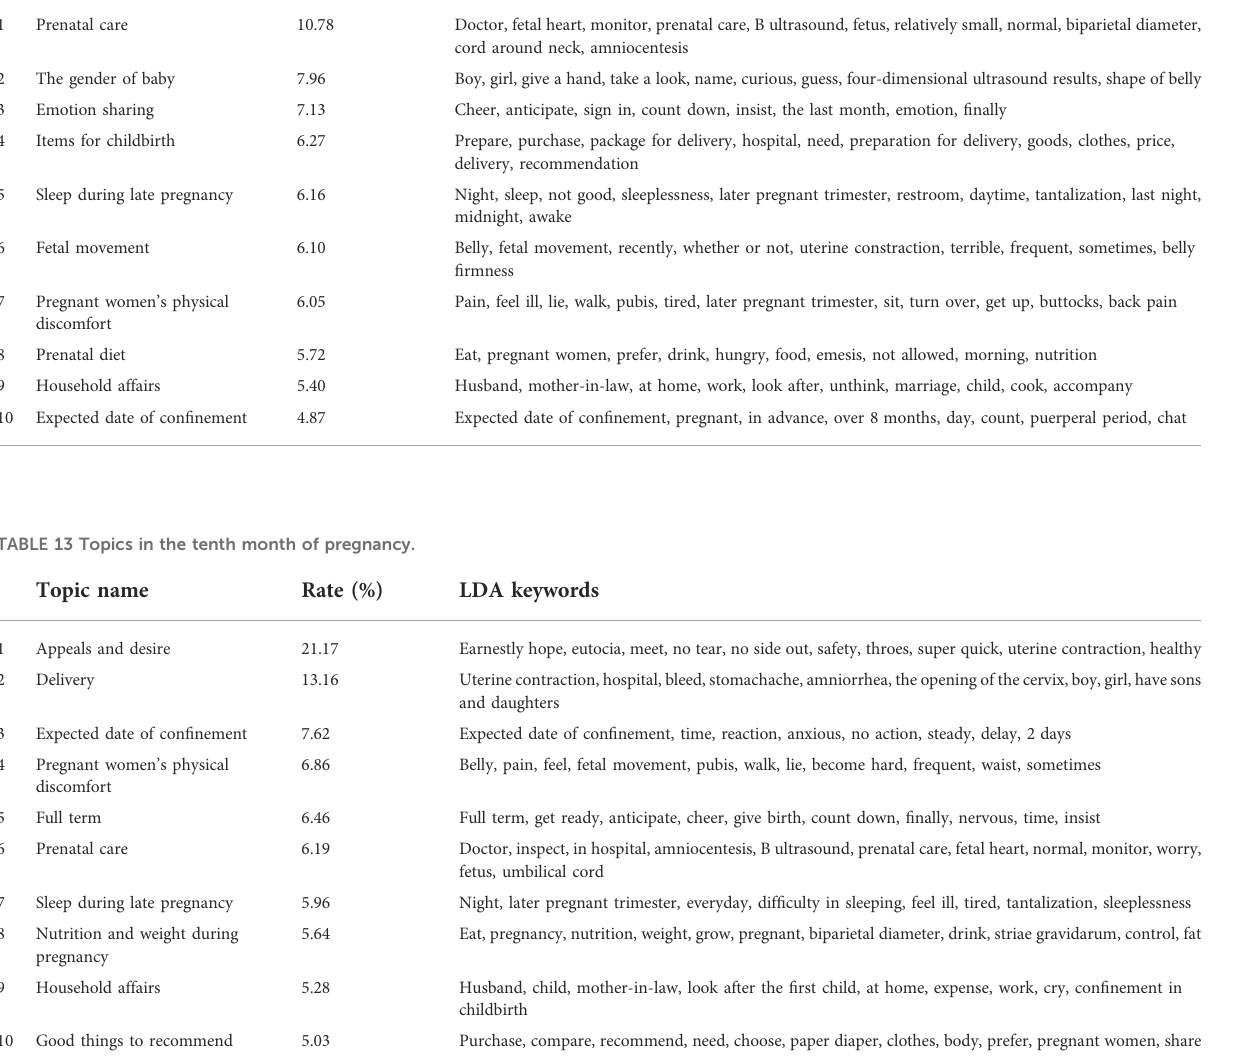
pregnancy. The results are presented in Figure 2. In word cloud statistics, word frequency is distributed by font size. As shown in Figure 2, the fonts of words such as “ pregnancy, ” “ child, ” and “ fetus ” are prominent, indicating that the topic of pregnancy is centered on pregnant women and babies. Secondly, the fonts of